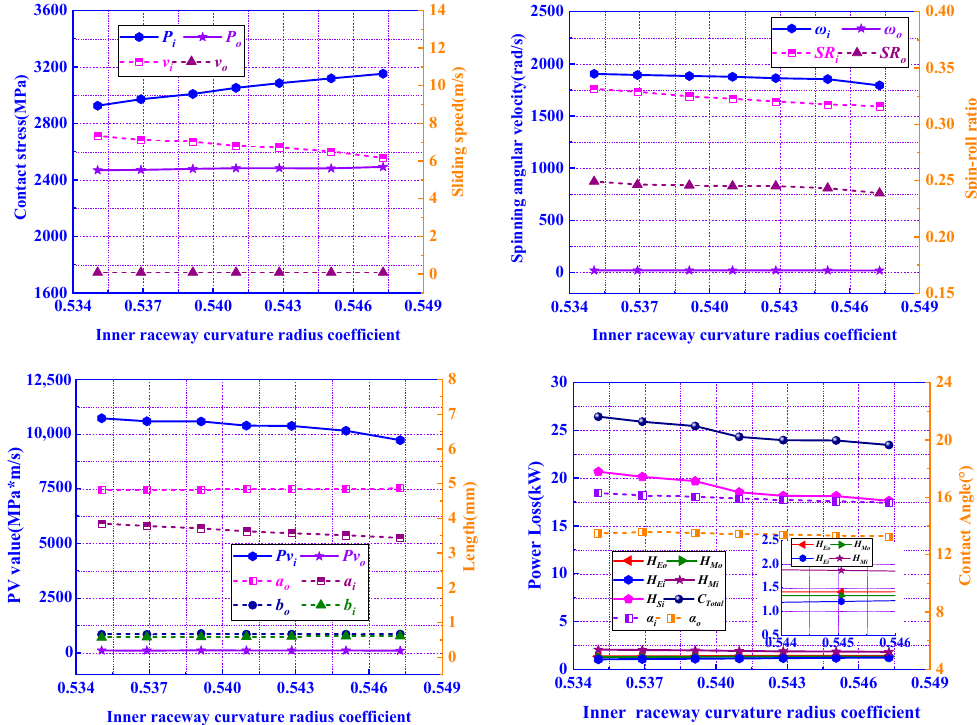
f on power loss. Figure 16. Influence of inner raceway curvature radius coefficient f i on power i f on power loss. i